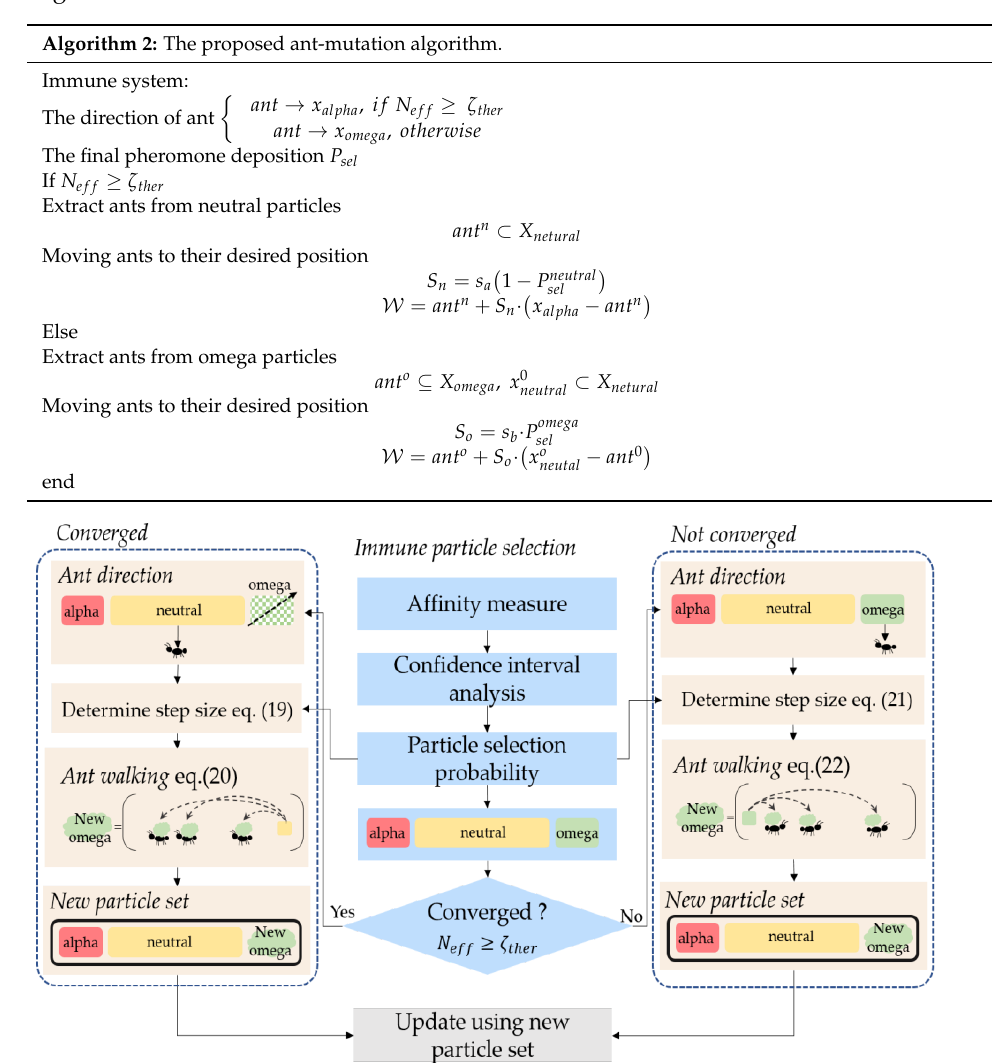
Figure 4. Proposed ant-mutation scheme. Algorithm 2 : The proposed ant-mutation algorithm.